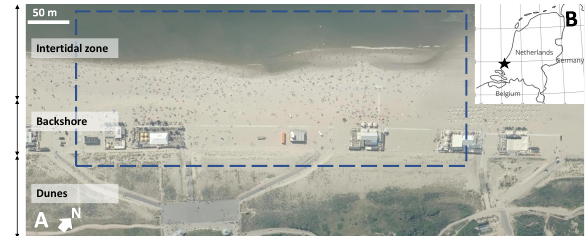
Figure 2. Temporal evolution and extracted spatial segment of an intertidal sandbar erosion surface